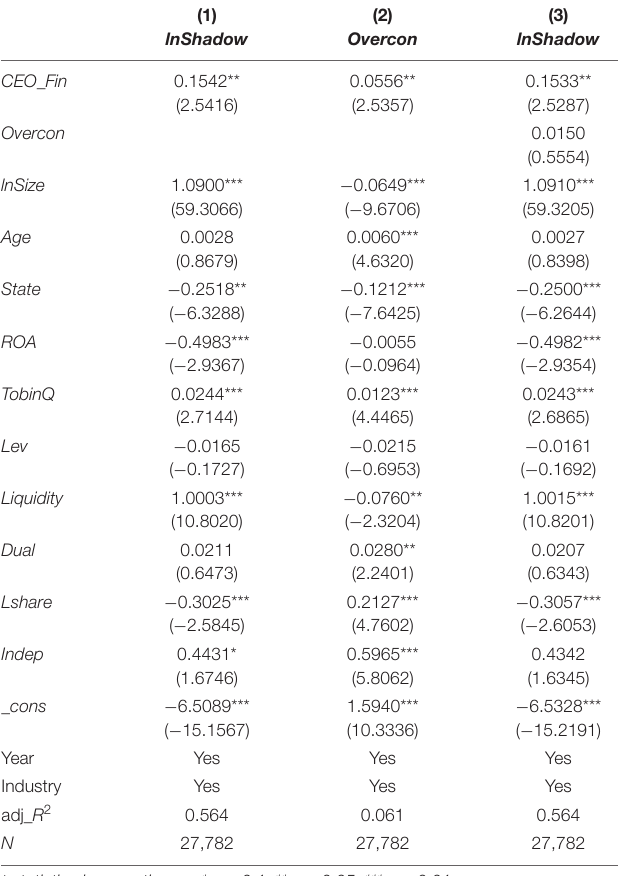
TABLE 6 | CEOs’ FB, overconfidence, and shadow banking business of non-financial